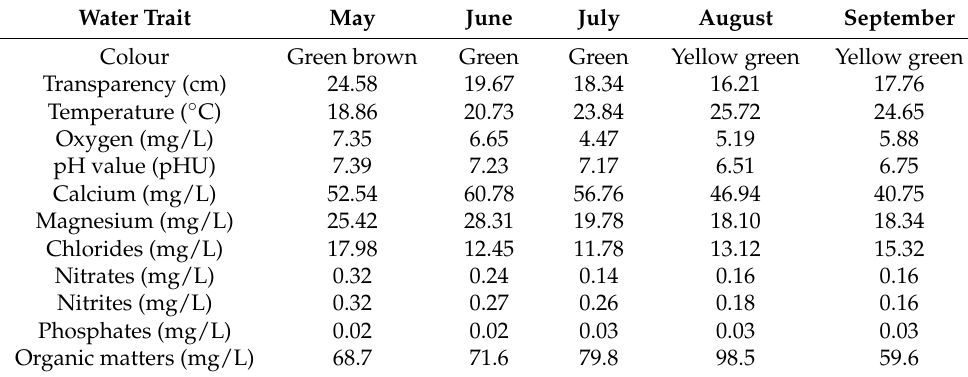
Table 2. Water quality traits in the paddlefish rearing